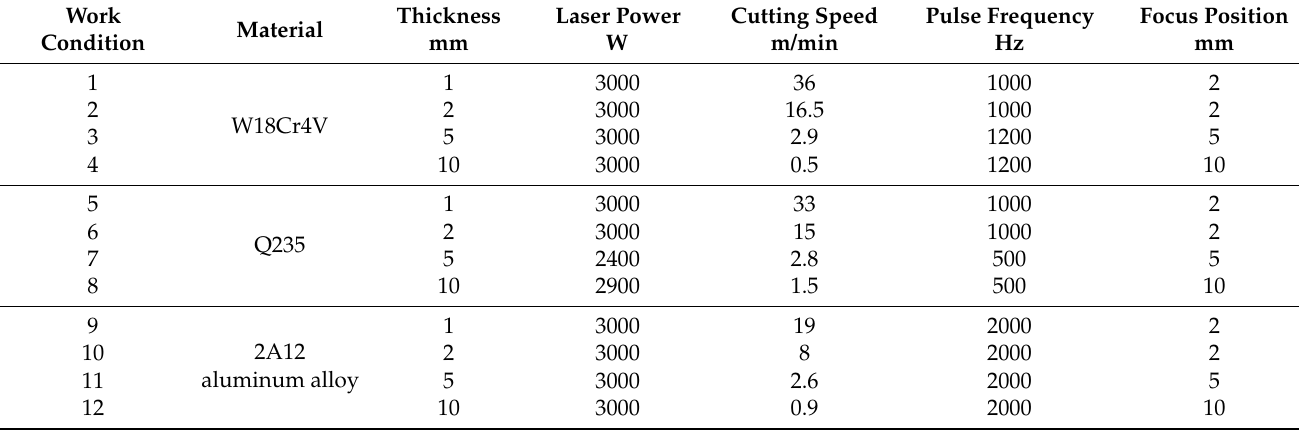
Table 2. Initial processing